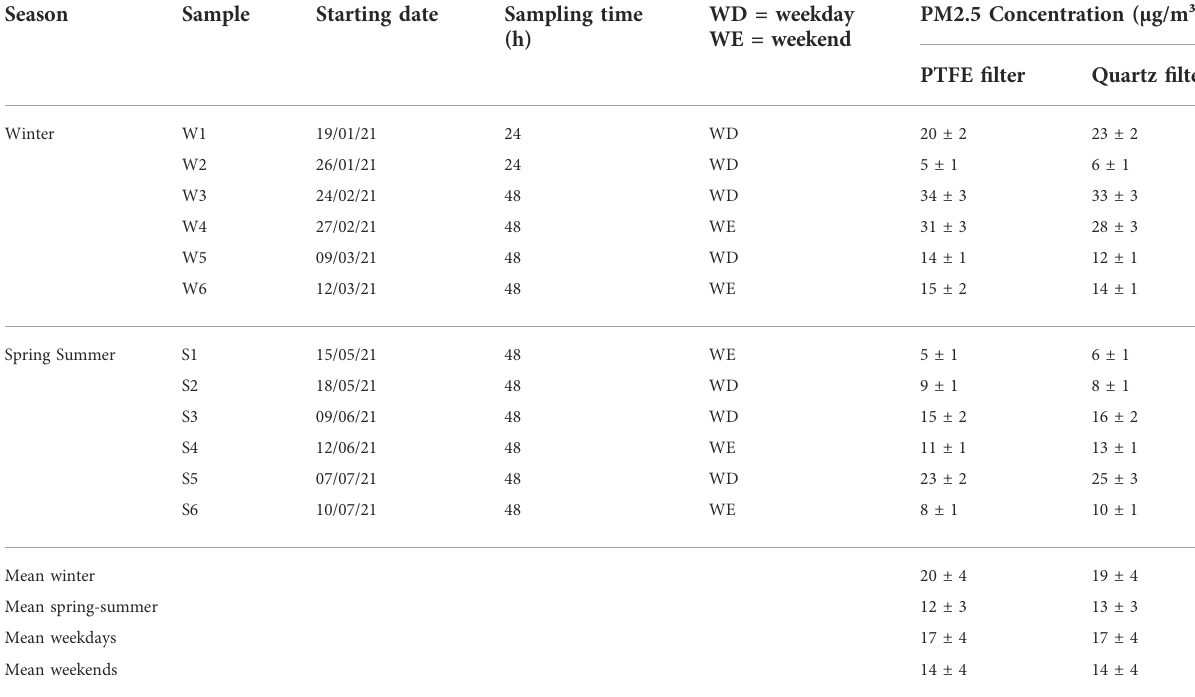
TABLE 1 PM2.5 concentrations (± corresponding uncertainties) determined using PTFE and quartz fi lters for each analyzed sample. The season, starting date, sampling time, and weekday/weekend indication have been also reported for each analyzed sample. The corresponding mean values (± standard error of the mean) for winter, spring-summer, weekday, and weekend samples have been also